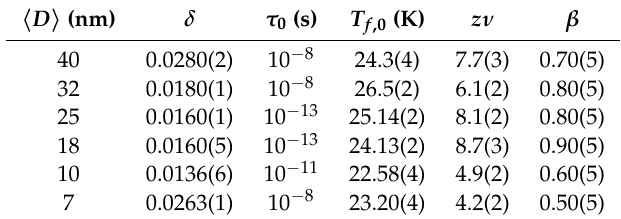
Table 4. δ -shift parameter, relaxation time τ 0 of individual particles for f → 0, freezing transition temperature T f , critical exponent z ν and β critical exponent for all of the GdCu 2 NPs. (cid:104) D (cid:105)